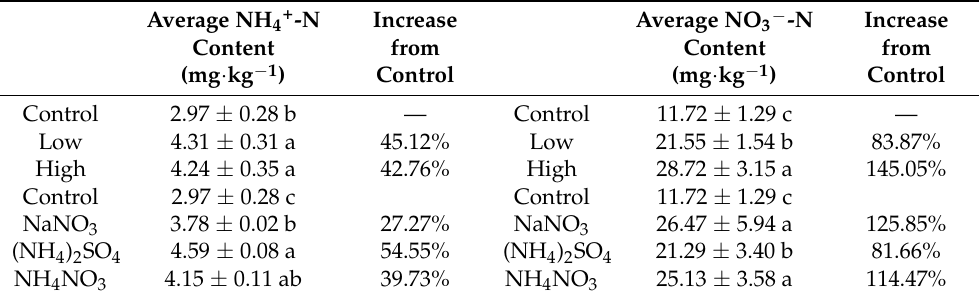
Table 2. Average NH 4+ -N and NO 3 -N content in control and N addition